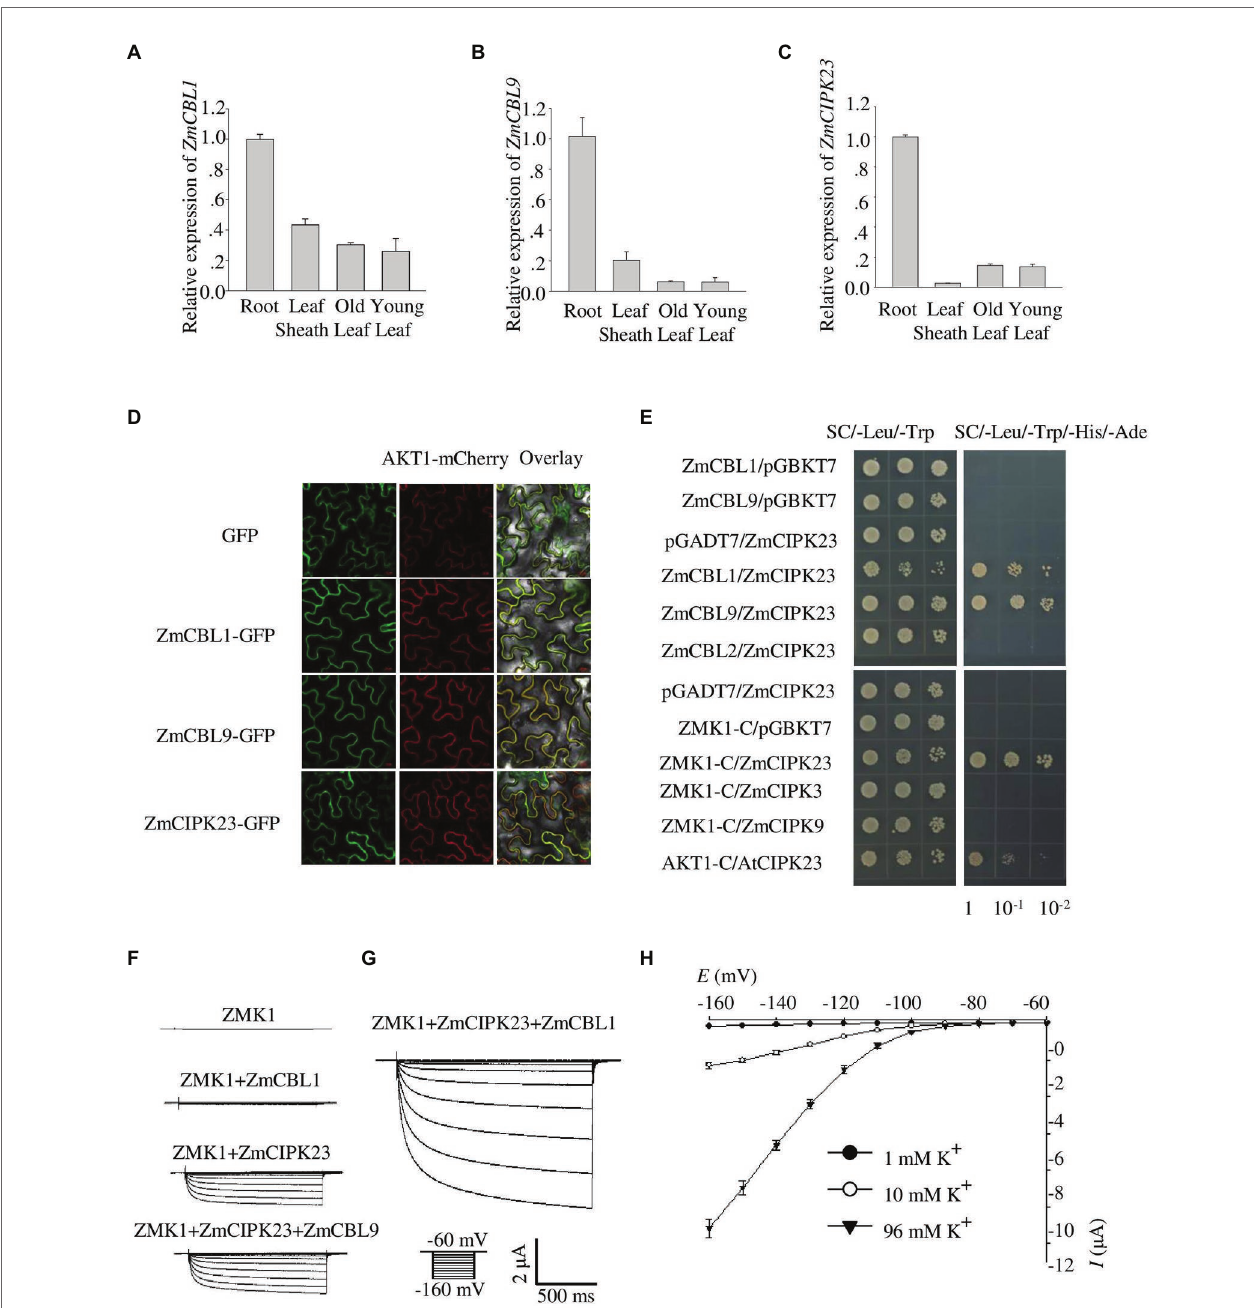
FIGURE 3 | Identification of ZmCBL1, ZmCBL9, and ZmCIPK23. (A–C) ZmCBL1 , ZmCBL9 and ZmCIPK23 expression levels in root, leaf sheath, old leaf, and young leaf in V3 stage were quantified by quantitative reverse transcription PCR (RT-qPCR) assay. Values were means ± SE ( n = 3). ZmGAPDH was used as a quantitative control. The data are obtained from three biological replicates. (D) Subcellular localization of GFP fusion proteins of ZmCBL1, ZmCBL9, and ZmCIPK23 in Nicotiana benthamiana . Bars = 20 μ m. AKT1-mCherry was used as the plasma membrane (PM) marker. (E) ZmCIPK23 interacted with ZmCBL1, ZmCBL9, and the cytosolic region of ZMK1 in yeast two hybrid assays. The blank pGADT7 and pGBKT7 vector were used as controls. (F) From top to bottom, representative currents trace upon voltage clamp pulses from − 60 to − 160 mV in oocytes expressing ZMK1, ZMK1+ZmCBL1, ZMK1+ZmCIPK23, and ZMK1+ZmCIPK23+ZmCBL9, in 96 mM K + solution at pH 7.2. Values were means ± SE ( n = 5 oocytes). (G) Representative currents trace upon voltage clamp pulses from − 60 to − 160 mV in oocytes expressing ZMK1+ZmCIPK23+ZmCBL1, in 96 mM K + solution at pH 7.2. Values were means ± SE ( n = 5 oocytes). (H) Steady-state current-voltage ( I-V ) relationships for ZMK1 co-expressed with ZmCIPK23 and ZmCBL1 in 96 mM K + solution at pH 7.2. The external potassium concentration is 1 mM (black circle), 10 mM (open circle), and 96 mM (black triangle). Data are shown as means ± SE ( n = 5